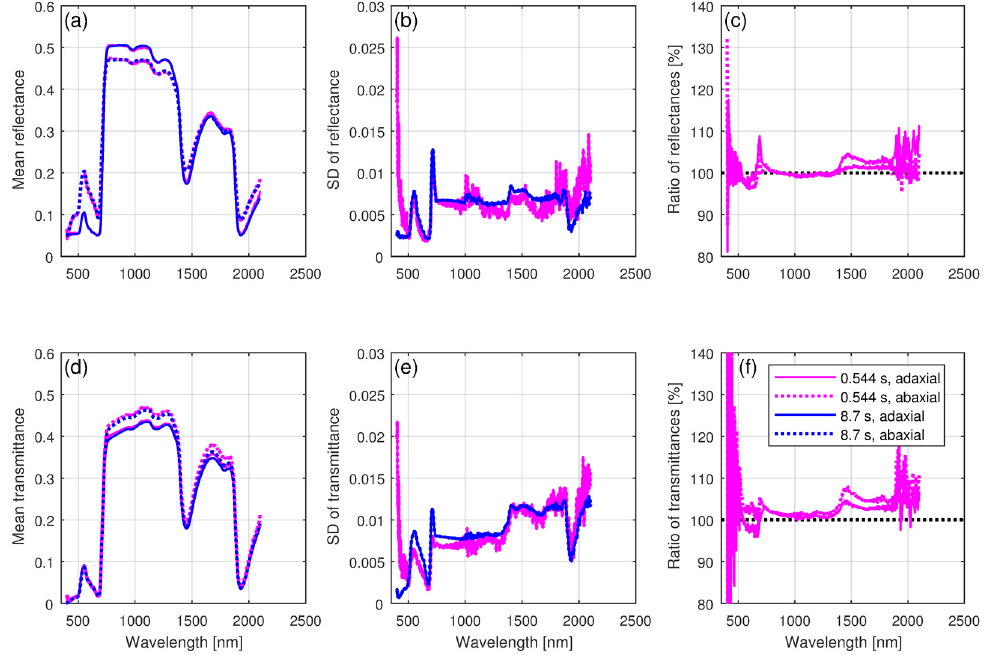
Figure 3. Comparison of birch leaf spectra measured with double integrating sphere, using either 8.7 s or 0.544 s integration time. ( a ): Mean reflectance; ( b ): Standard deviation of reflectance; ( c ): Ratio of mean reflectances (0.544 s to 8.7 s); ( d ): Mean transmittance; ( e ): Standard deviation of transmittance; ( f ): Ratio of mean transmittances (0.544 s to 8.7 s).